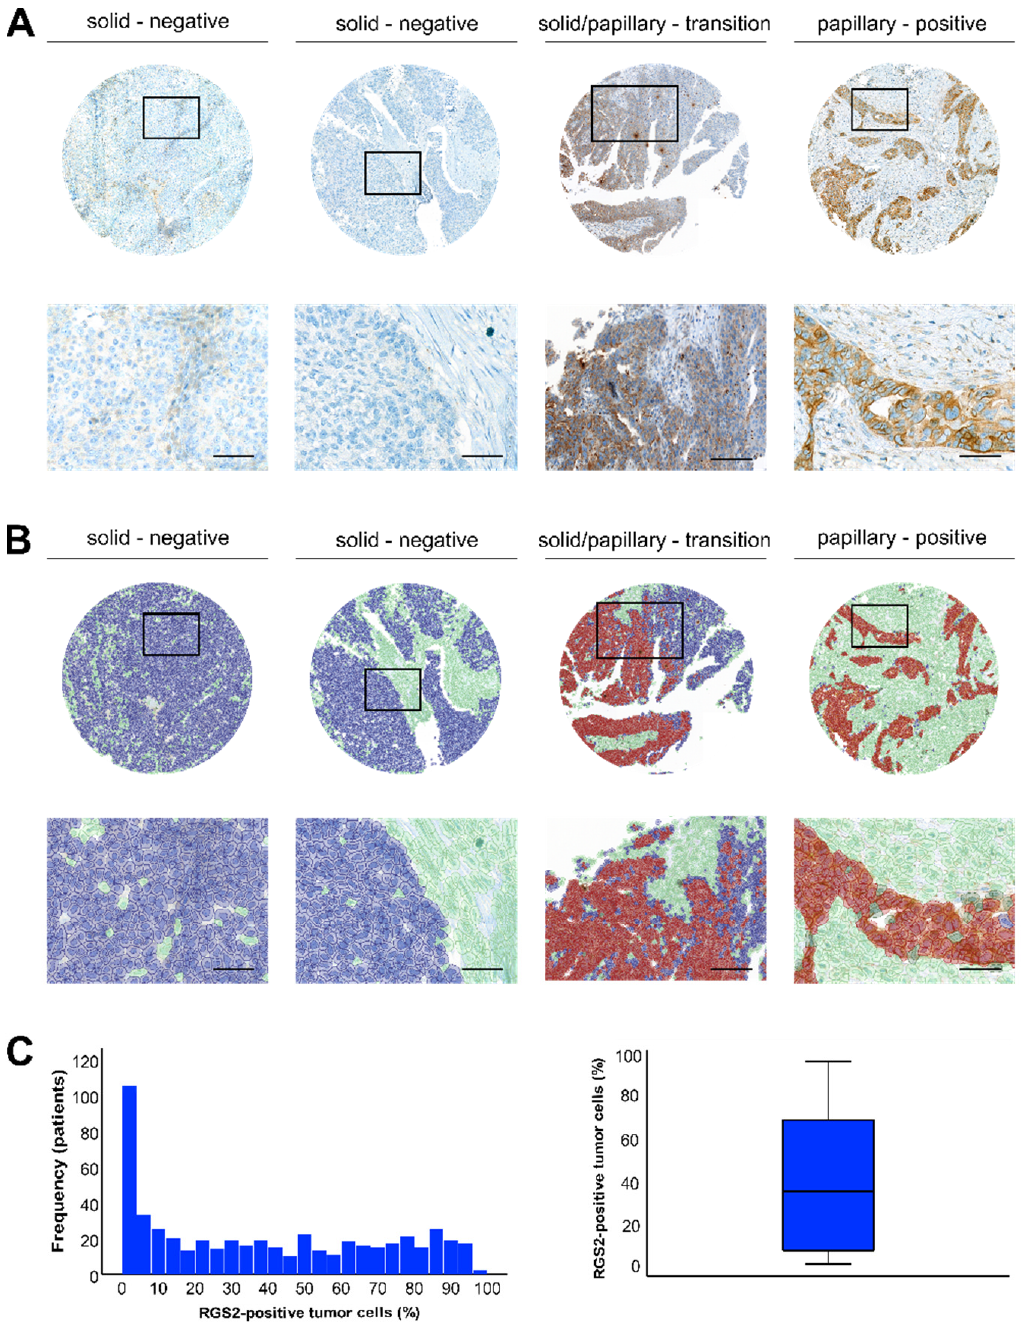
Figure 1. RGS2 protein expression pattern and distribution in HGSOC. ( A ) RGS2 by immunostaining in primary HGSOC with regard to growth patterns. In solid or disseminated tumor areas, RGS2 staining was negative in the majority of cases. In papillary areas, RGS2 staining was predominantly positive and distributed homogenously. In transition zones both positive and negative areas were visible. ( B ) Detected cells were color-coded according to their classification: green = non-tumor cells, blue = RGS2-negative tumor cells, red = RGS2-positive tumor cells. Panel images are magnifications of boxed areas in upper panel images. Scale bars (left → right): Picture 1 and 2: 120 µm, Picture 3: 250 µm, Picture 4: 80 µm. ( C ) Distribution of RGS2-positive tumor cells in the entire cohort. Most tumor cells were RGS2 negative or showed weak RGS2-expression; however, approximately half of the patients showed detectable RGS2-expression in ≥ 50% of tumor cells .